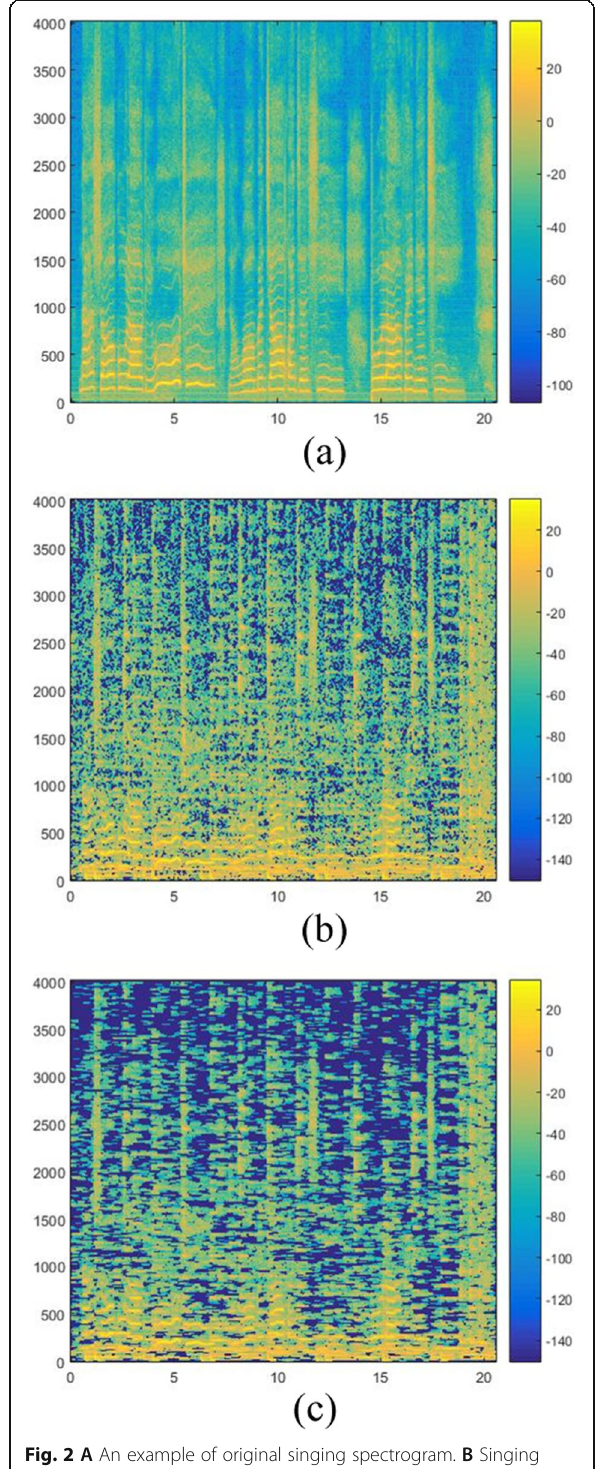
Fig. 2 A An example of original singing spectrogram. B Singing spectrogram after RPCA with soft mask and median filter. c Singing spectrogram after applying morphology to the soft mask M